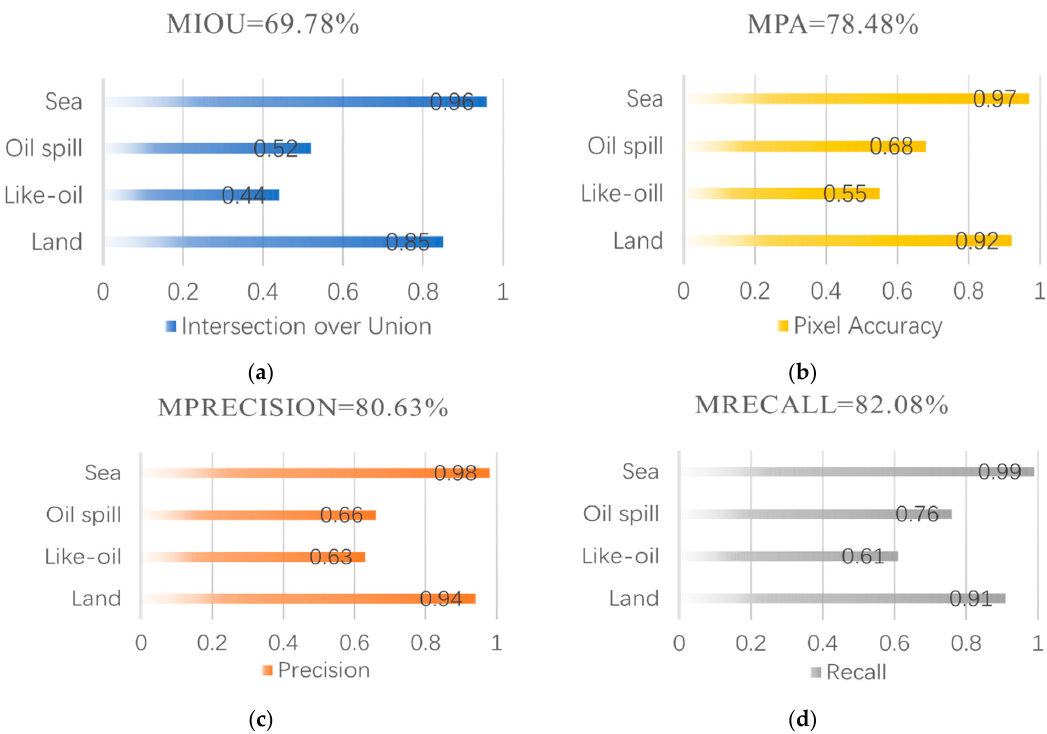
Figure 6. Training results obtained on ASA-DRNet. ( a ) mIOU; ( b ) mPA; ( c ) mPrecision; ( d )